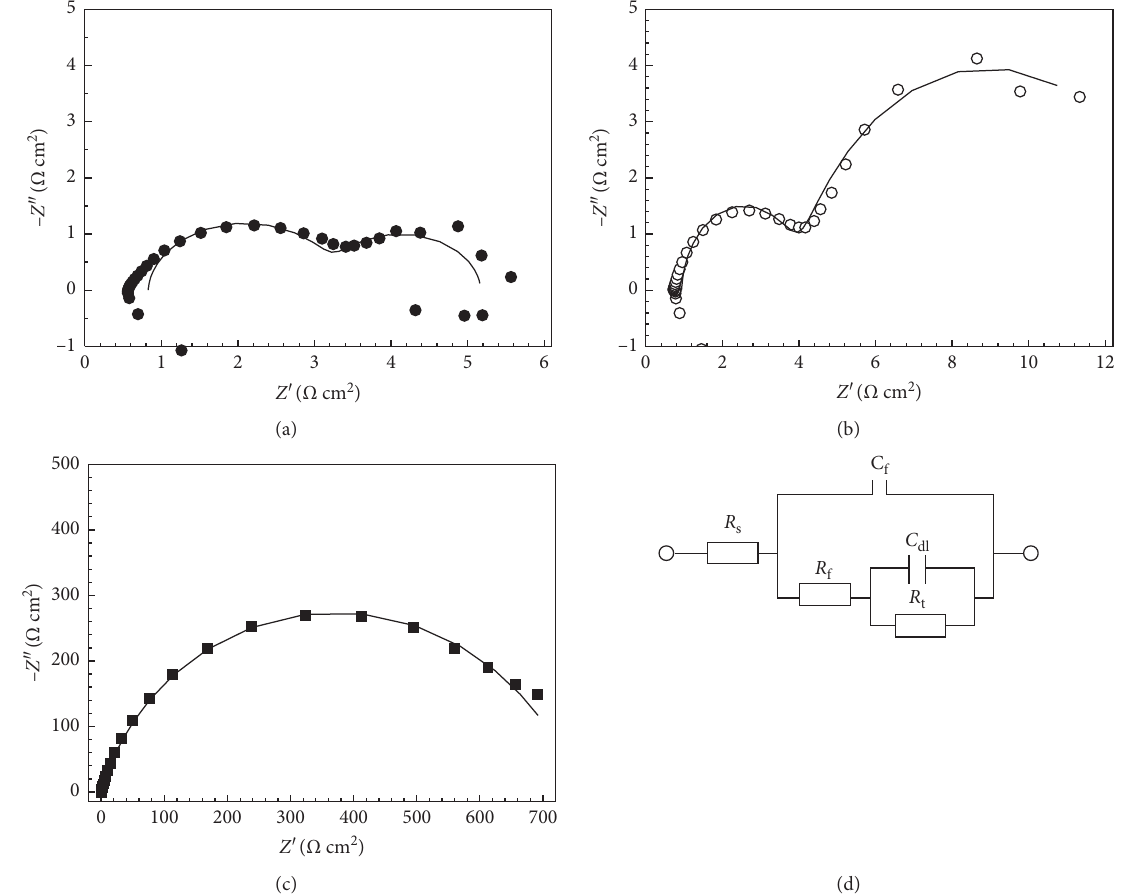
Figure 13: Nyquist plots in 300g L − 1 H ° C containing no ions (a), 10gL − 1 Fe 2+ (b), and 10gL − 1 Fe 3+ (c), and the 2 SO 4 solutions at 75 corresponding circuit of the impedance spectrum